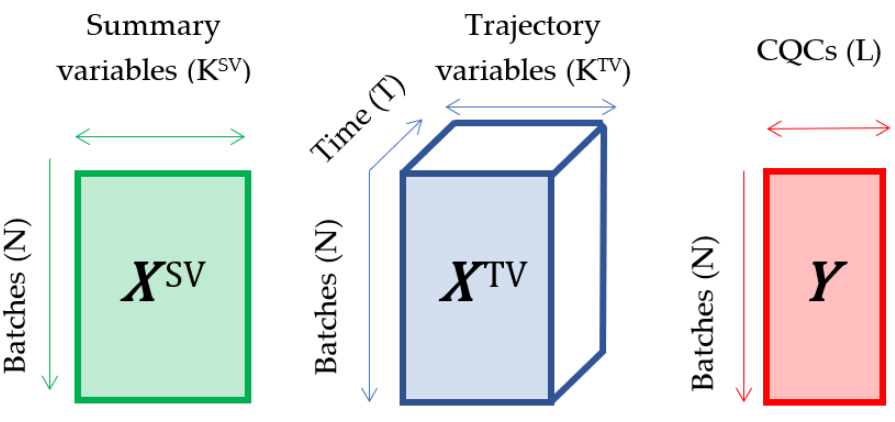
Figure 1. Nature of the batch data